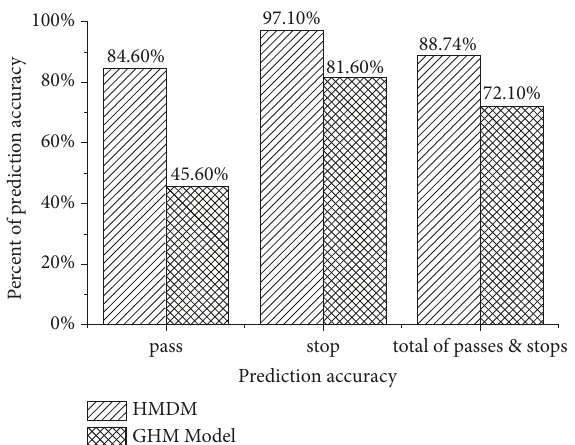
Figure 4: Comparison of prediction accuracybetween HMDM and GHM